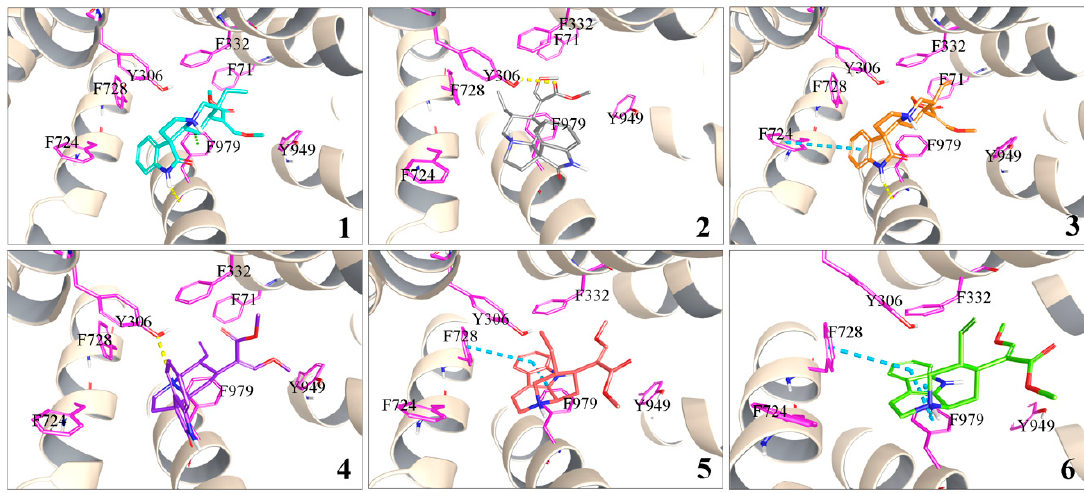
Figure 5. Docked complex of P -gp and alkaloids 1 – 6 . Yellow, blue, and green dashed lines represent hydrogen bonds, π - π bond and p - π bond, respectively.